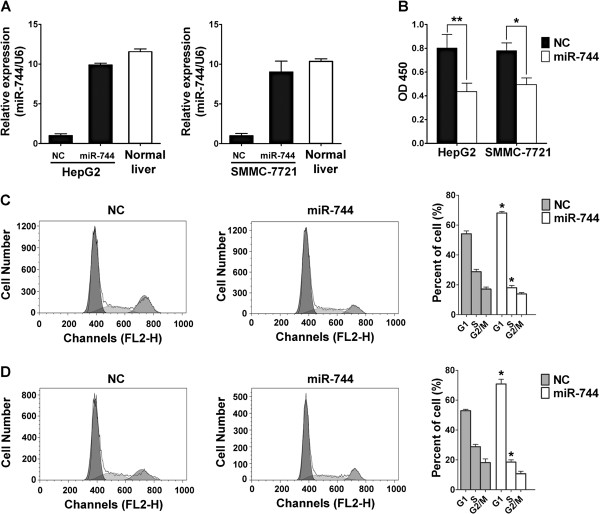
MiR-744 restoration inhibit the viability of HCC cells. (A) miR-744 expression was quantified by qRT-PCR analysis. miR-744 mimics restorated miR-744 expression in both HepG2 and SMMC-7721 cells. (B) Proliferation assay of HCC cells in response to miR-744 restoration. HepG2 or SMMC-7721 cells were seeded into 96-well plates and incubated in the presence of miR-744 mimics or negative control oligonucleotides. Cell proliferationassay was done after culturing for 72 h. (C, D) Cell-cycle distribution was analyzed by FACS analysis. HepG2 (C) and SMMC-7721 (D) cells were transfected with miR-744 mimics or negative control oligonucleotides. Nocodazole (25 ng/ml) was added 24 h after transfection for another 16 h, then the supernatant was replaced by fresh medium for 6 h. The data were subjected to Student's t-test. *p < 0.05, **p < 0.01. NC, negative control oligonucleotides.